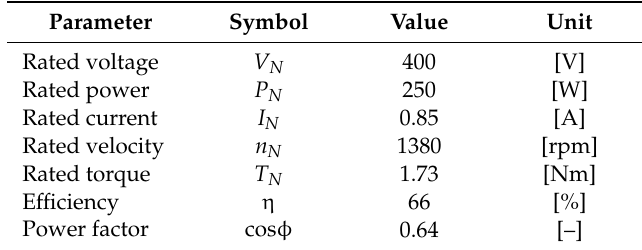
Table 1. Rated parameters of induction motorSH-71-4a.